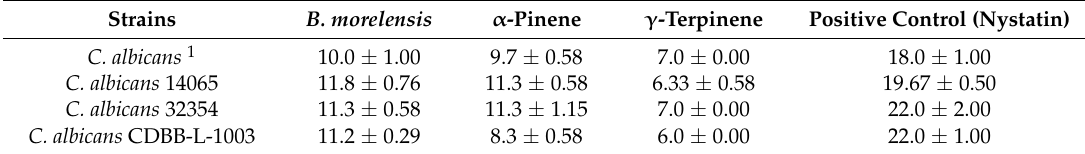
Table 2. Anti- Candida activity of essential oil from B. morelensis , α -Pinene and γ -Terpinene.